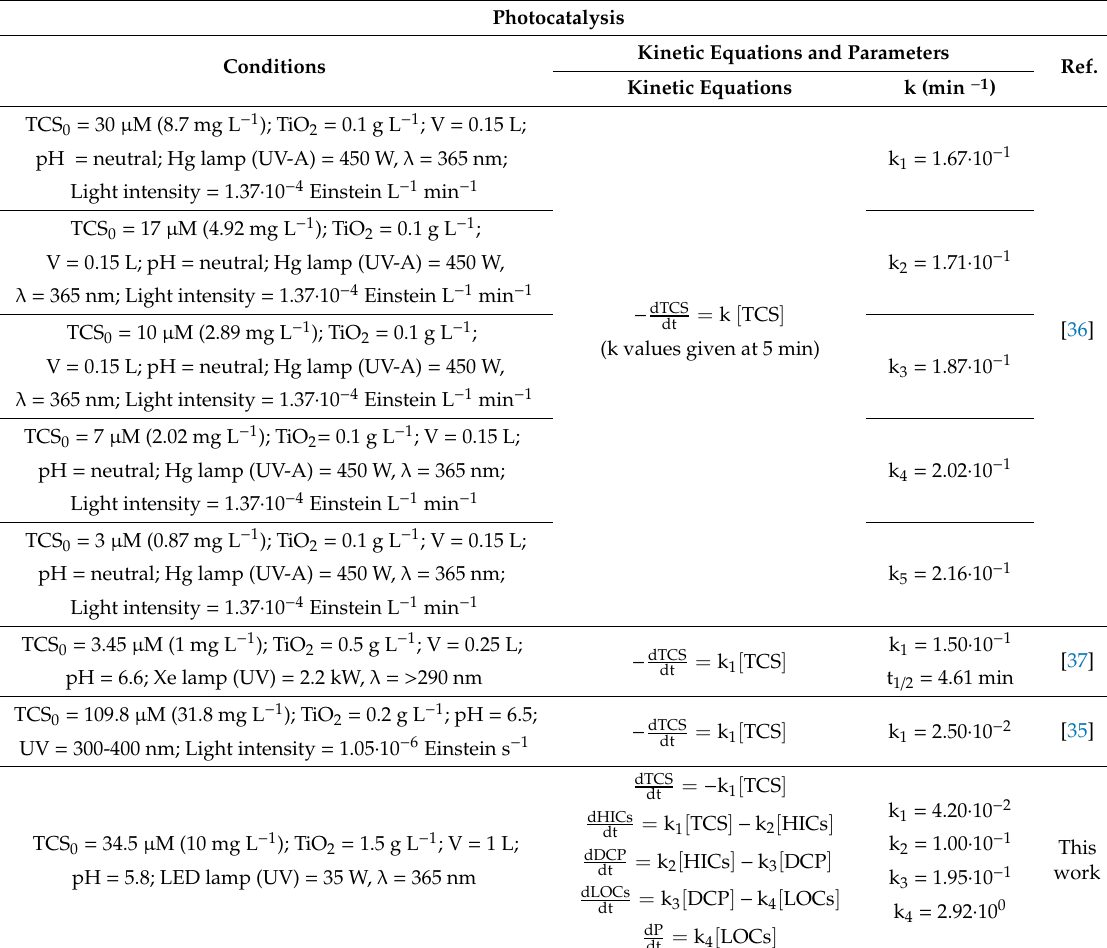
Table 2. TCS kinetic constants in photocatalytic